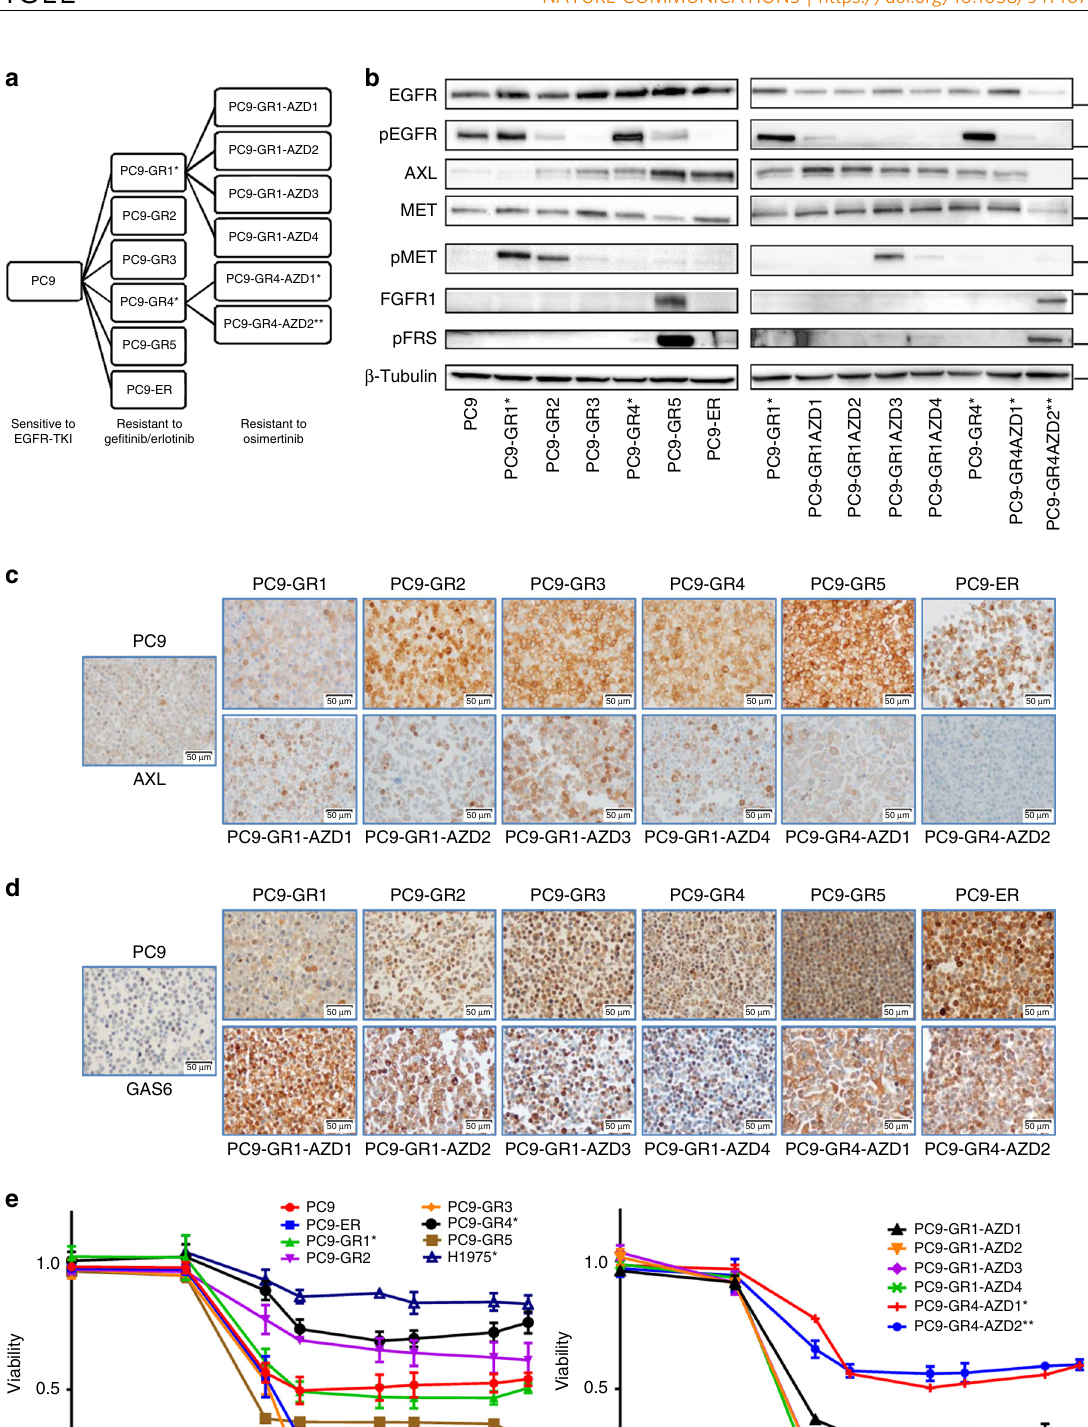
NATURE COMMUNICATIONS| (2019) 10:1812